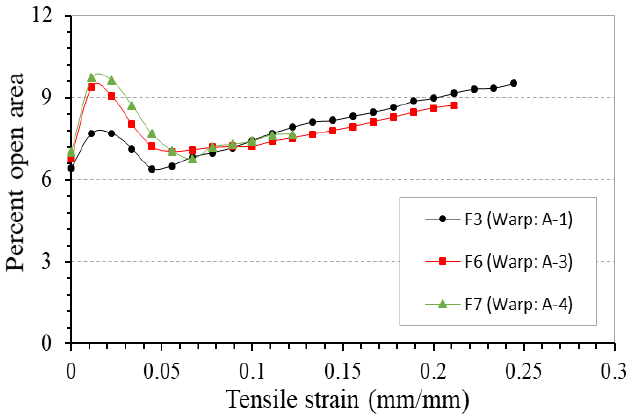
Figure 18. Percent open area-tensile strain curves of fabrics F3, F6 and F7.